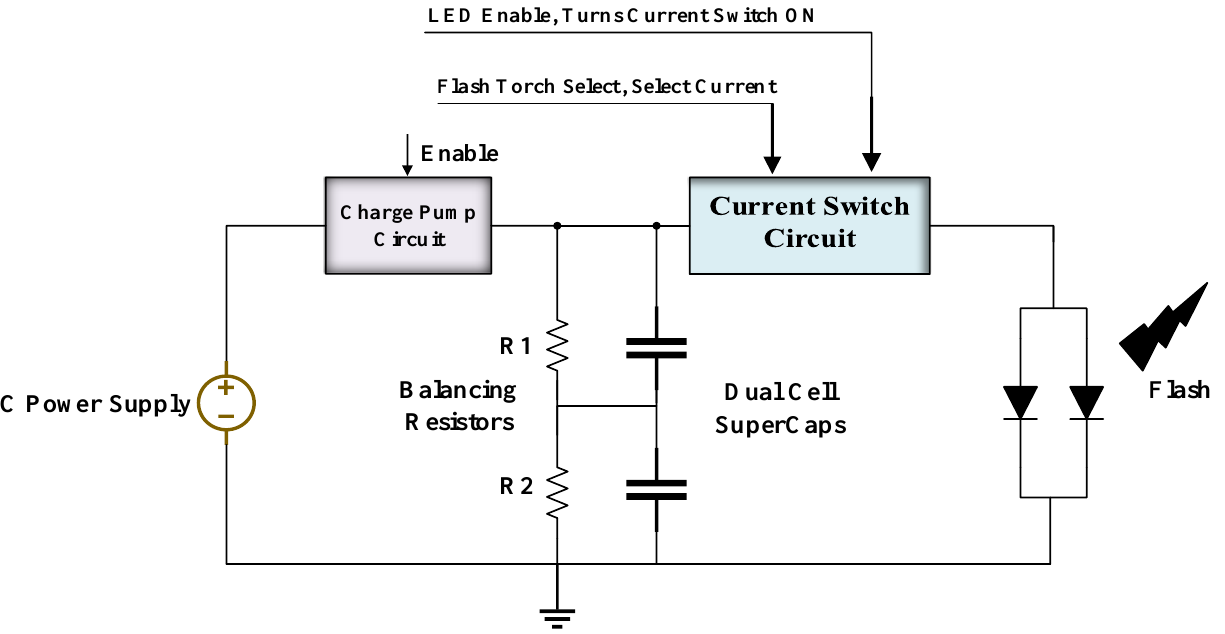
Figure 10. Camera Flash SC-based block diagram [58,59].